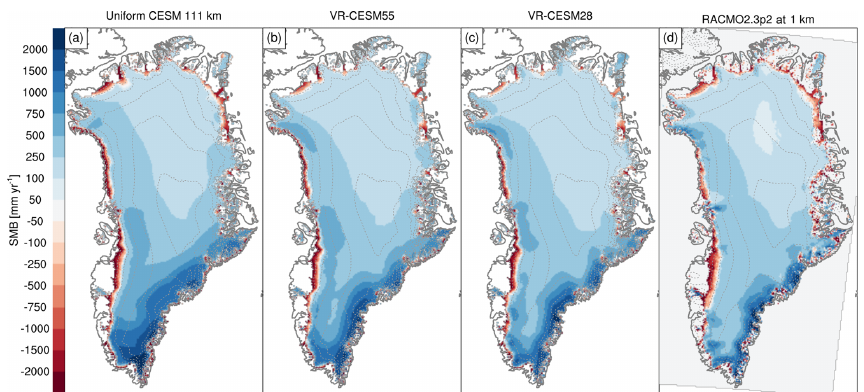
Figure 7. Mean annual SMB in millimetres of water equivalent per year. All CESM data are downscaled to 4km CISM resolution for the period 1980–1999. RACMO2 data have been statistically downscaled from 11 to 1km. Note the non-linear colour scale. Table 2. Mean GrIS mass fluxes for the period 1980–1999 in gigatonnes per year with standard deviation between brackets. The area of integration is listed in the first column and includes peripheral glaciers and ice caps (GIC). CESM data are integrated at the native resolution with elevation class weighing. The statistically downscaled 1km RACMO2.3p2 data are averaged over the same period and described in Noël et al. (2018). RACMO2 does not differentiate between snow and ice melt in its output files so only total melt is